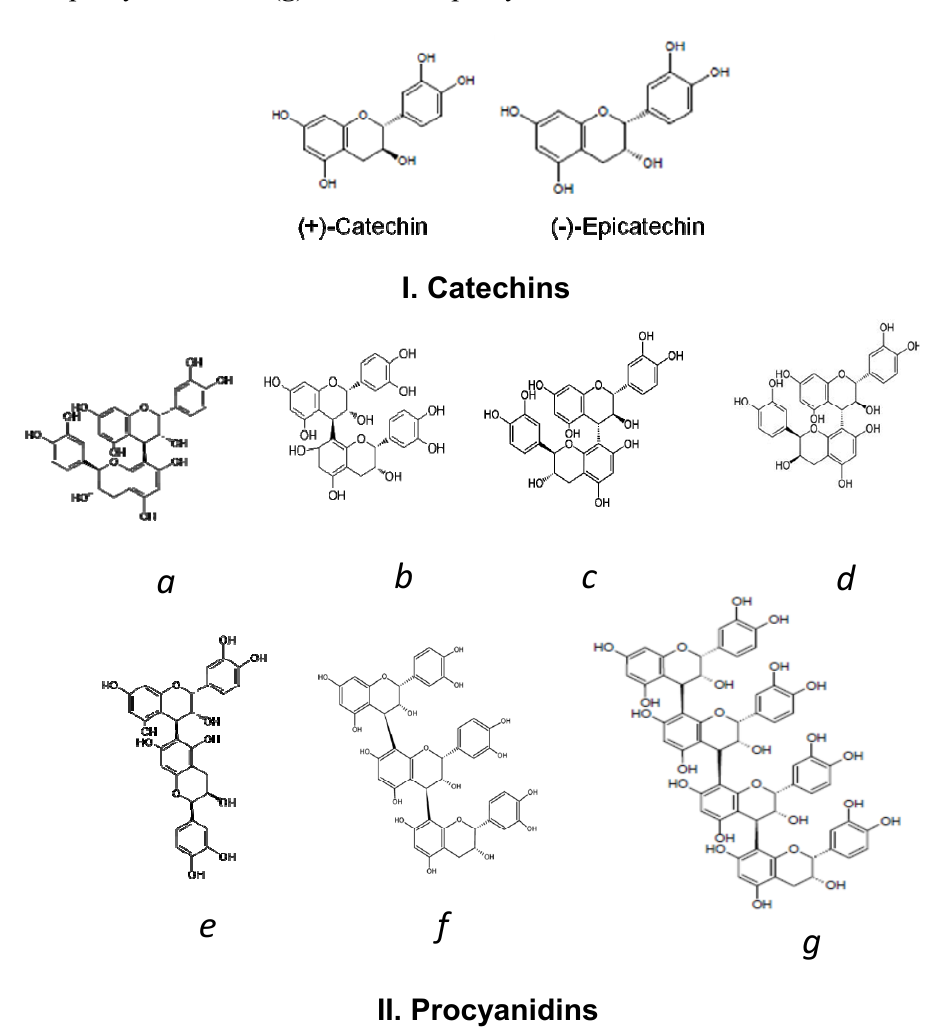
Figure 1. ( I ) Main cocoa flavanol monomers: (+)-catechin; ( − )-epicatechin; ( II ) Main ( f )—trimer: procyanidin C1; ( g )—tetramer: procyanidin